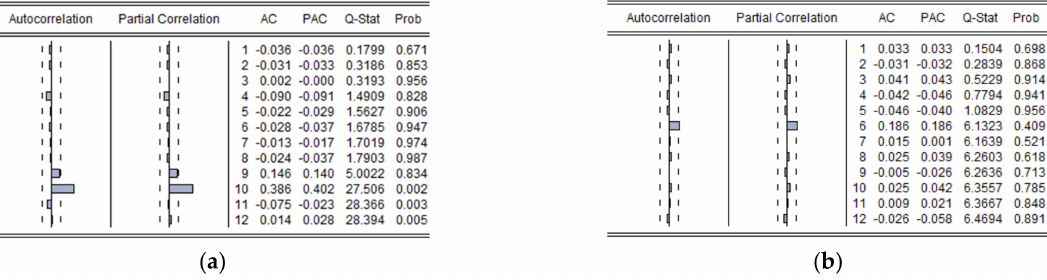
Figure 4. Sampled signal autocorrelation function and partial correlation function: ( a ) Sampling signal 1; and ( b ) Sampling signal